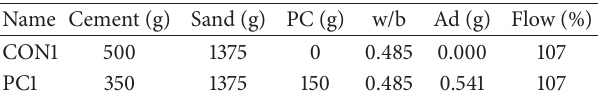
Table 2: Mortar mixture proportions for compressive strength determination.